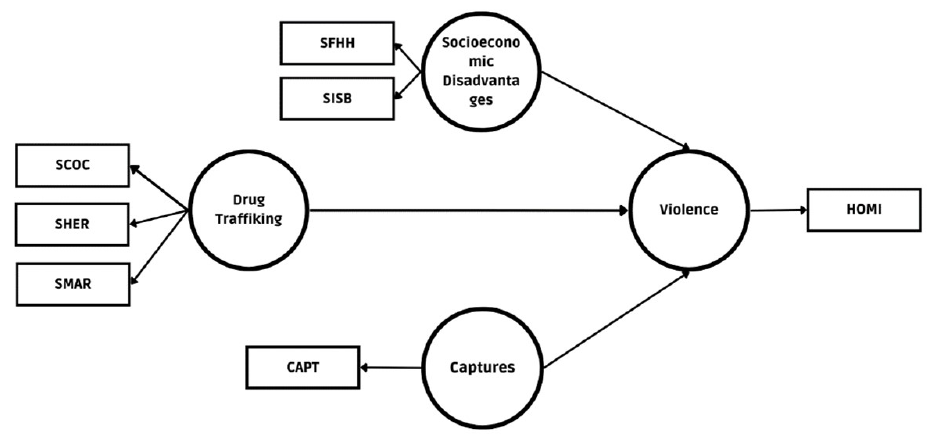
Figure 2. Theoretical